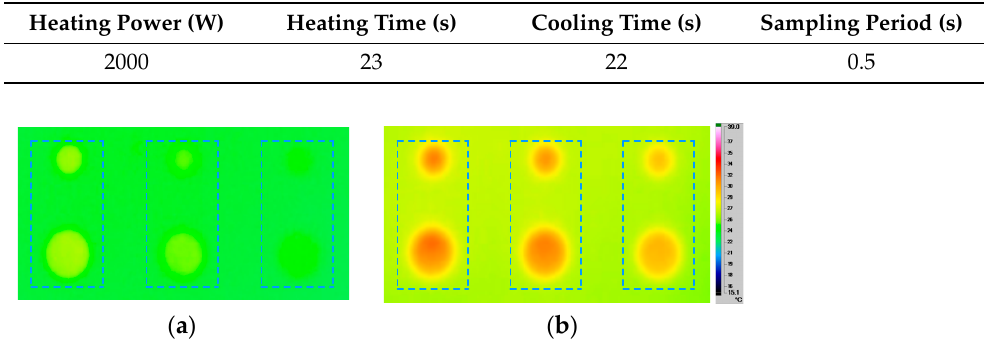
Figure 8. The temperature field distributions on specimen surface: ( a ) heated for 11 s; ( b ) cooled for 10.5 s. Table 2. The parameters of the experiment.